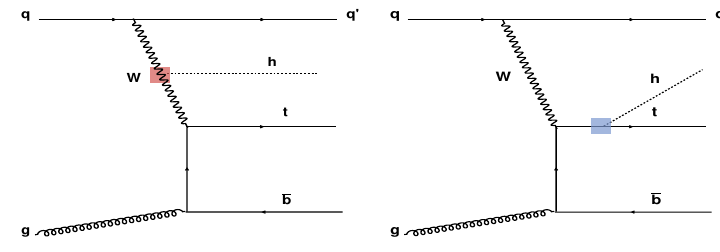
Figure 3 . Feynman diagrams contributing to thX production with X = jb .